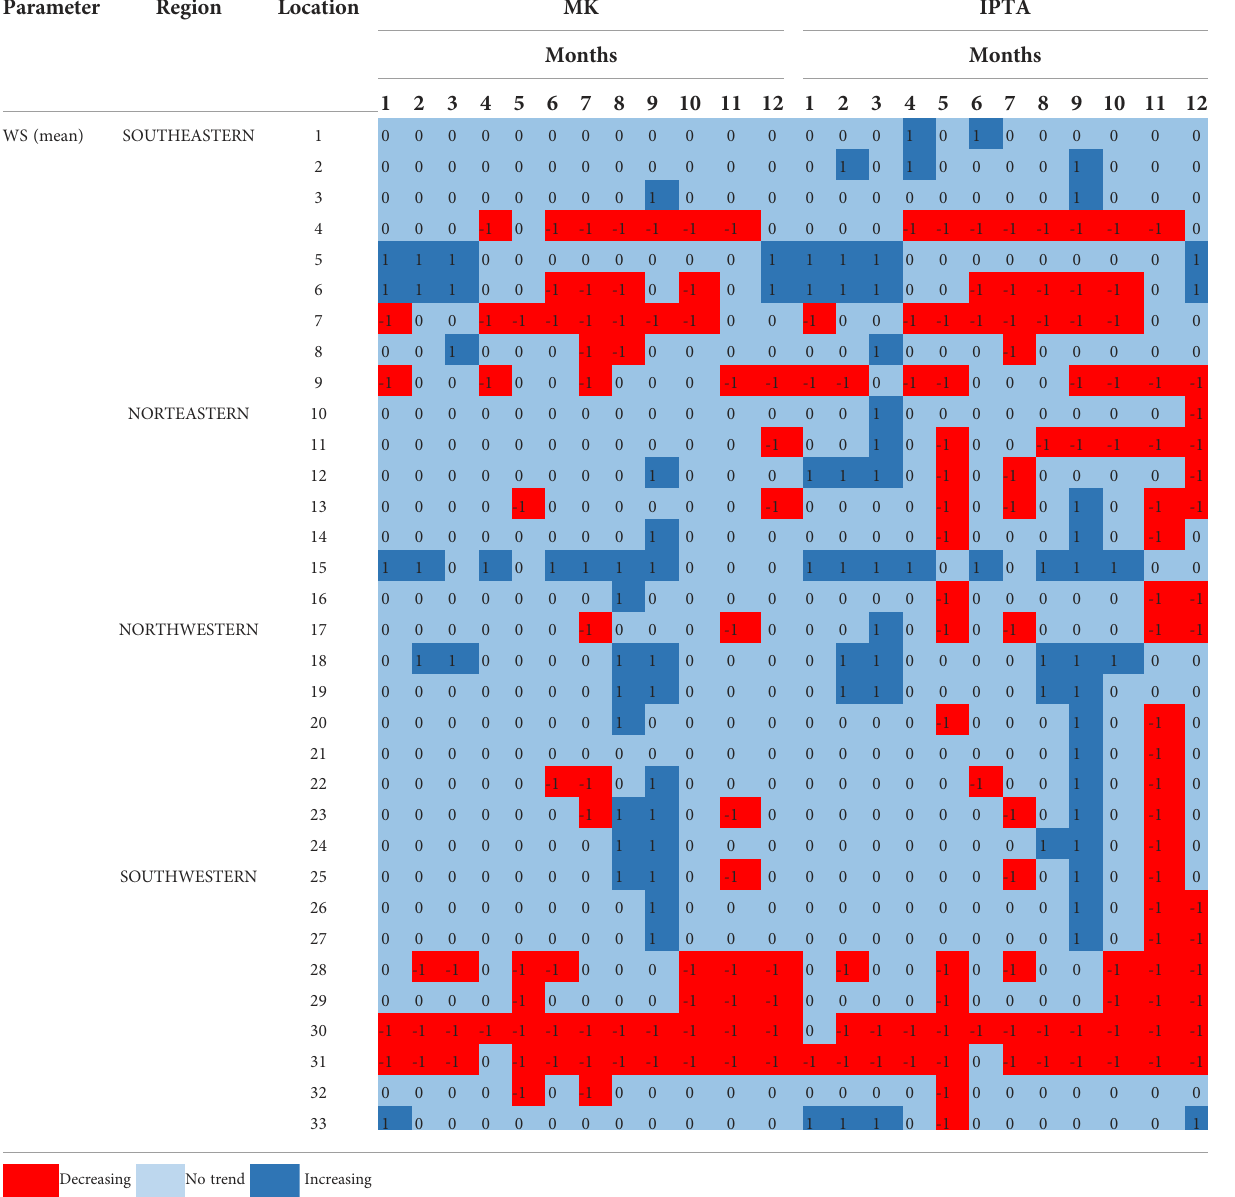
TABLE 3 Comparison of trend test results from different methods for mean WS.